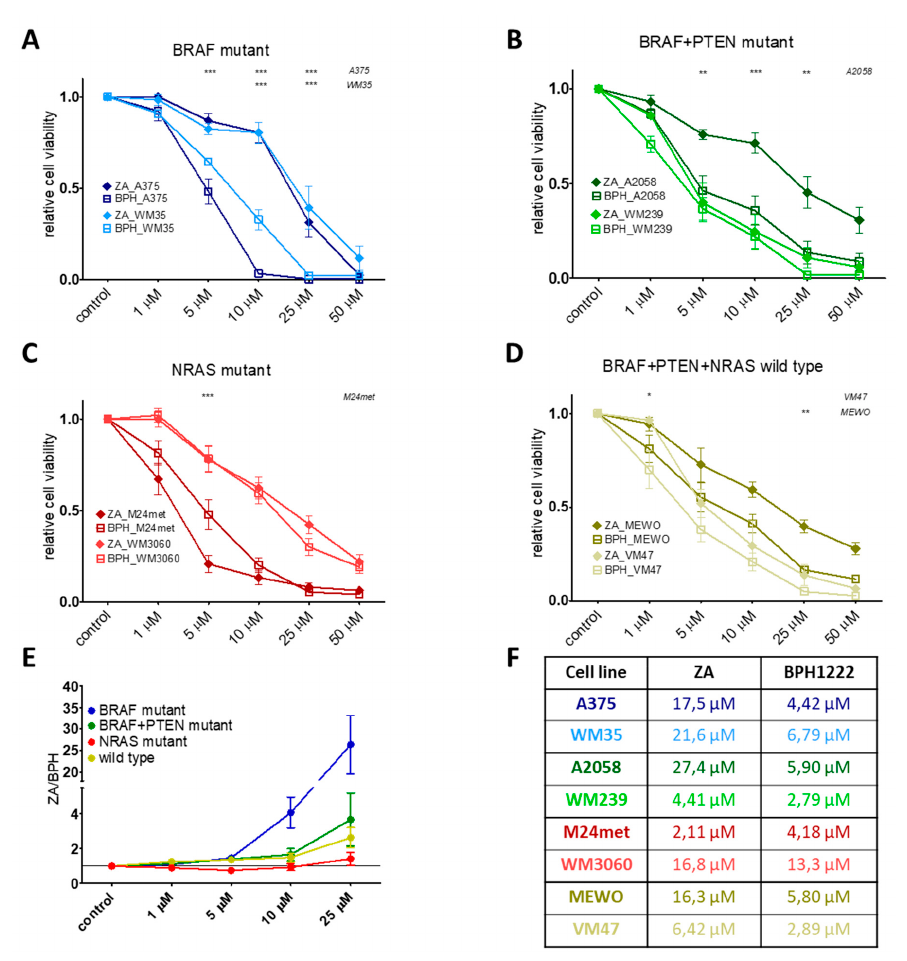
Figure 1. Short-term (72 h) sulforhodamine B (SRB) assay results on melanoma cell lines